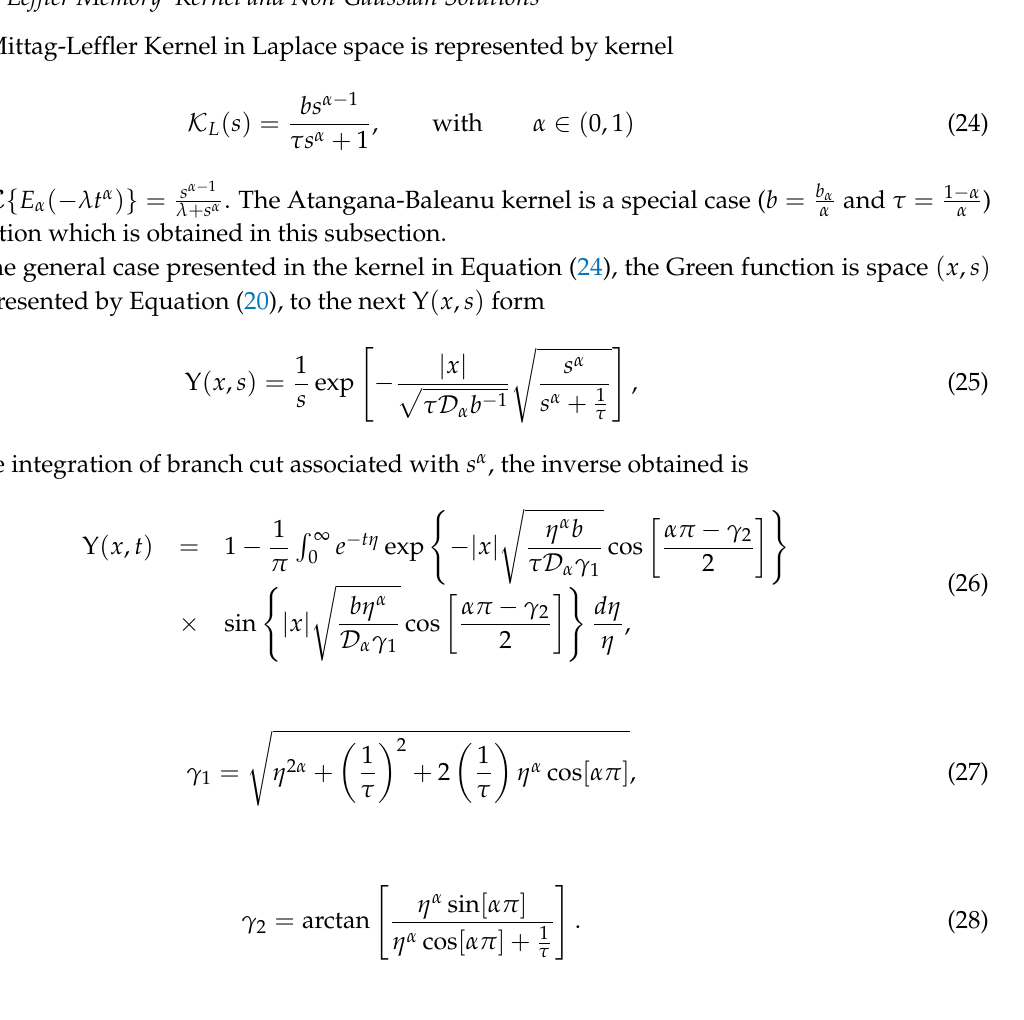
f − 1 = 1 and τ = 4 to different times D f − 1 = D